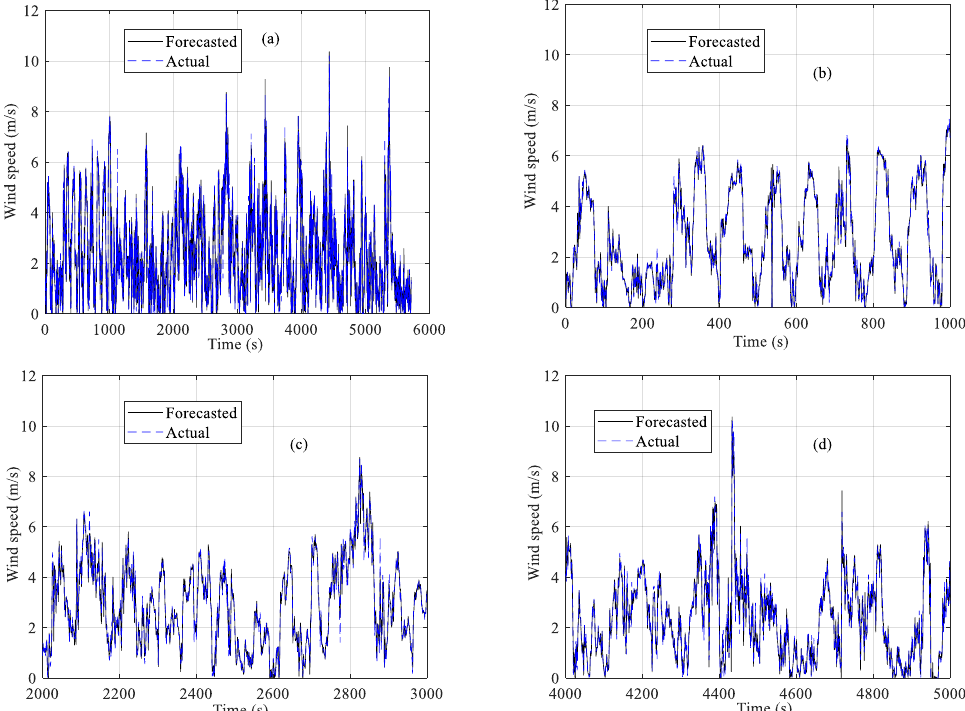
Figure 10. Forecasted and actual series of the test set referring to the 10 min ahead prediction horizon for all the examined time period ( a ), between 0 and 1000 s ( b ), between 2000 and 3000 s ( c ), and between 4000 and 5000 s ( d ).